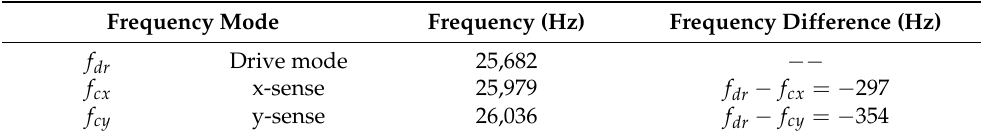
Table 1. Resonant Frequencies of the Designed MEMS Gyroscope.